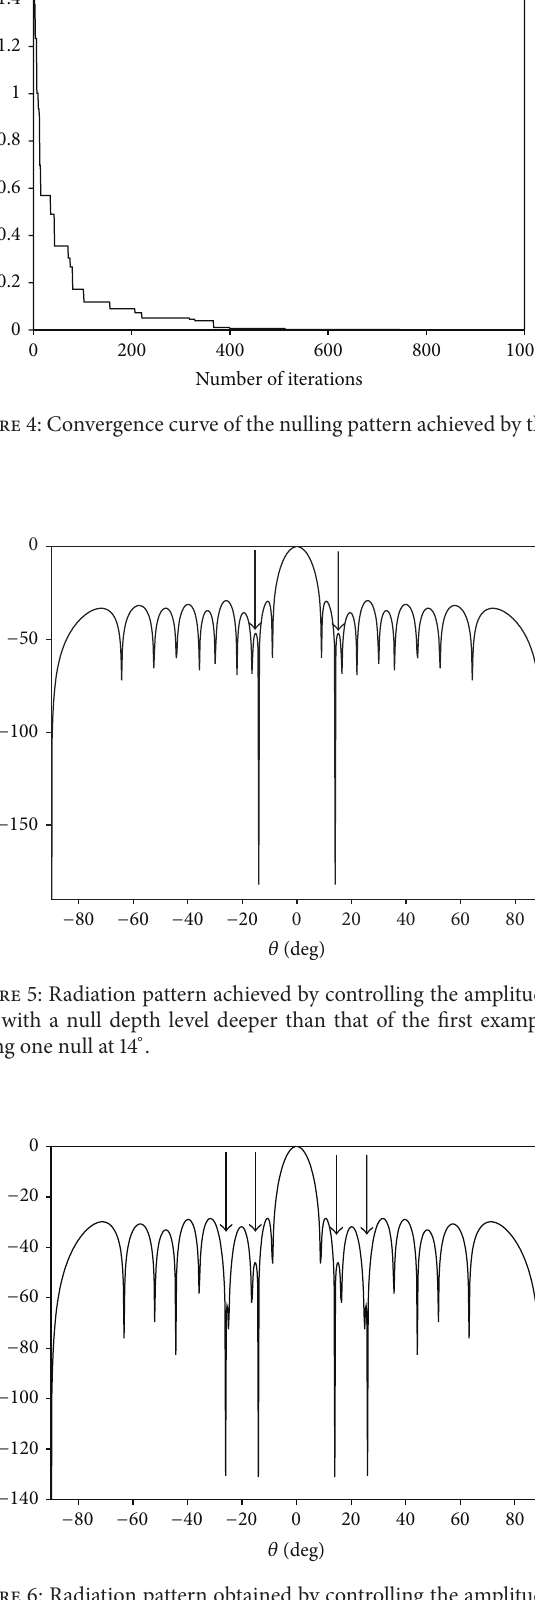
Figure 6: Radiation pattern obtained by controlling the amplitude only with double null at 14 ∘ and 26 ∘ .